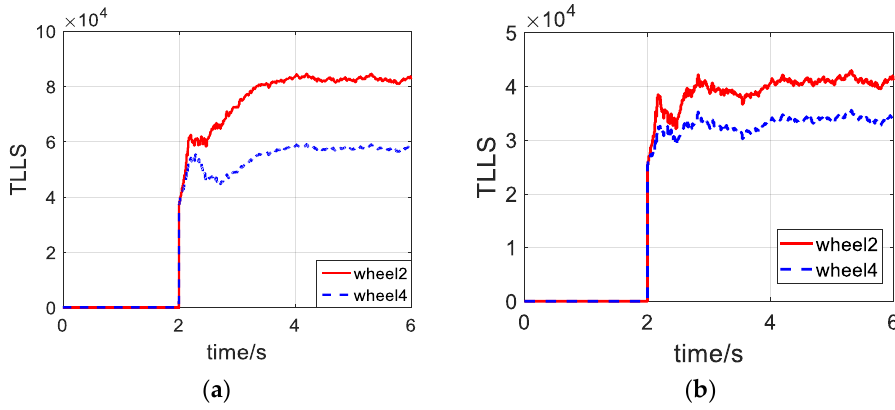
Figure 8. TLLS: ( a ) high adhesion coefficient road; ( b ) low adhesion coefficient road.